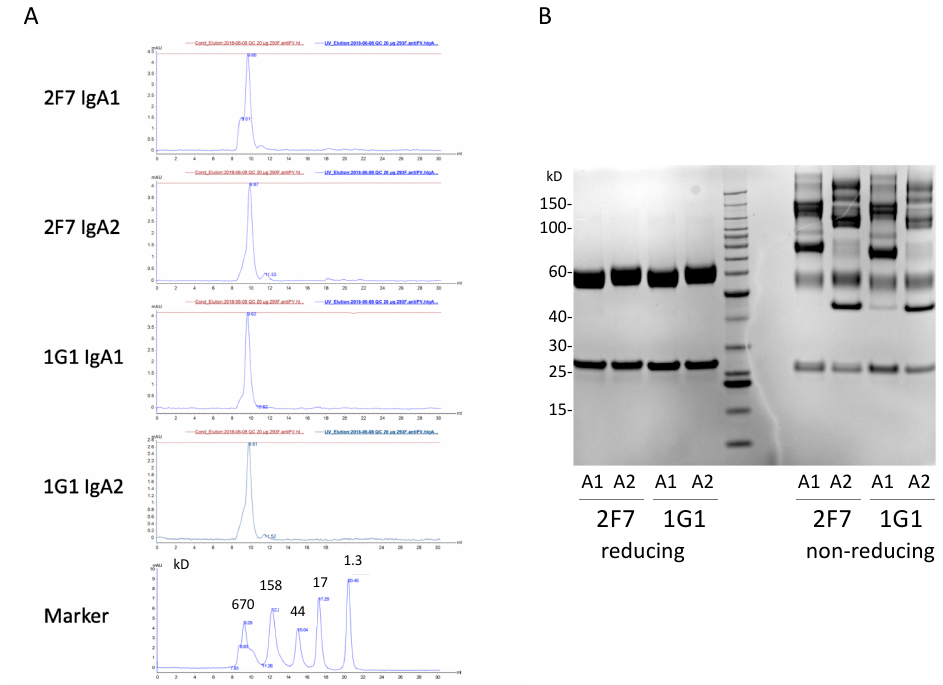
Figure 6. Analysis of the recombinant IgA mAbs after Protein L purification. ( A ) Gel filtration of 20 μ g mAb samples with a Superdex 200 Increase 10/300 GL column. Marker, Bio-Rad Gel Filtration Standards. ( B ) Analysis of the purified proteins on reducing (left) and non-reducing (right) SDS- PAGE.